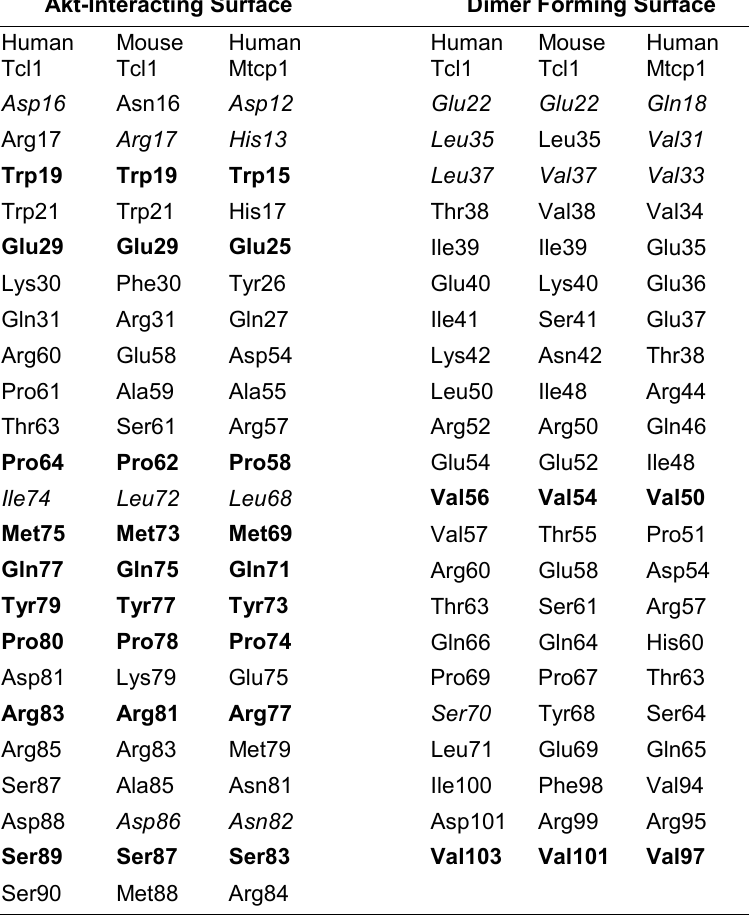
Comparison of Surface Residues for Human Tcl1, Mouse Tcl1,